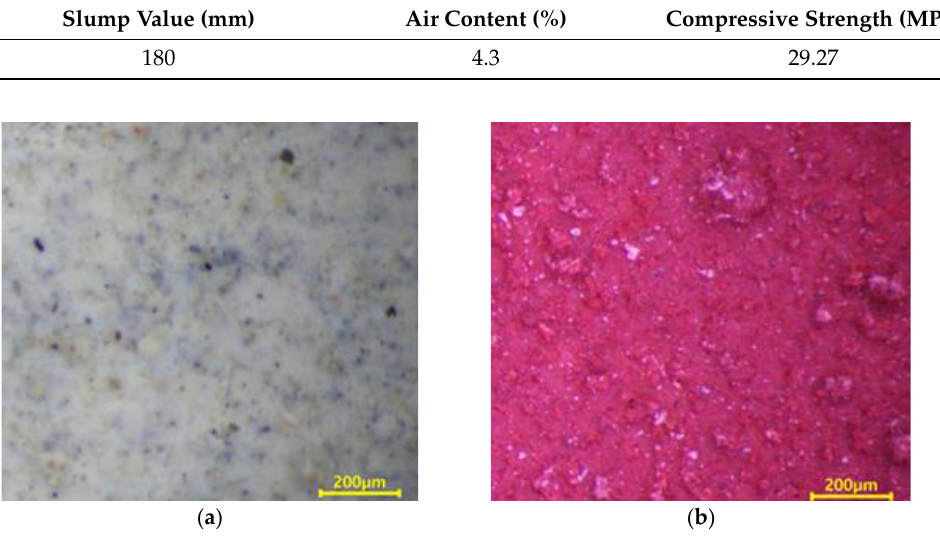
Figure 6. Surface images ( a ) SH and ( b ) SRA at 250x.